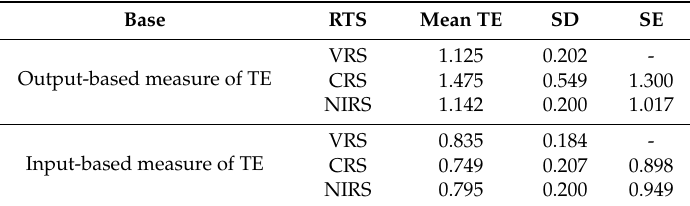
Table 4. Bootstrapped Debreu–Farrell TE.